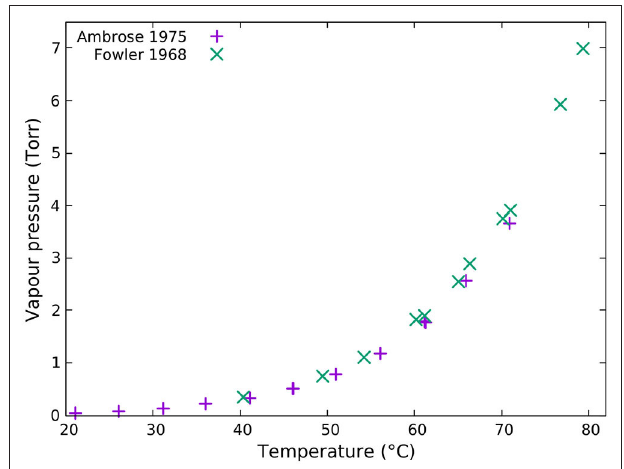
FIGURE 1 | Naphthalene vapor pressure vs. temperature as reported by [9] (purple “+”) and [ 10] (green